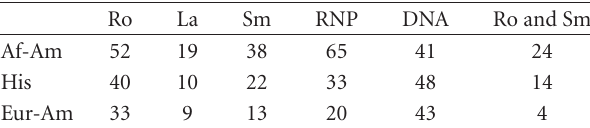
Table 1: Percent of SLE patients with a positive test for each SLE- associated autoantibody in each ancestral background.